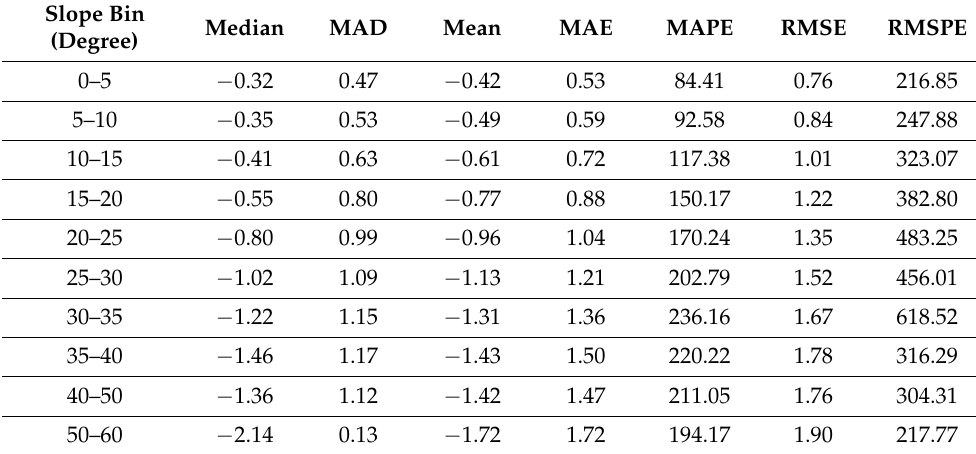
Table 8. Accuracy of GEDI total PAI estimates of individual footprints (11,832) for different slope bins. Statistics for differences in values (ALS PAI , GEDI PAI ).